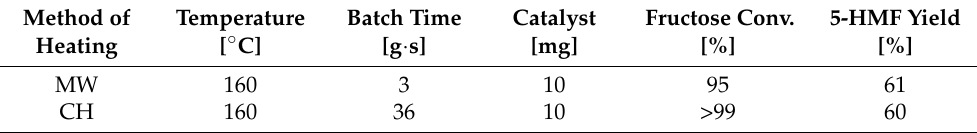
Table 5. Comparison between MW and CH for fructose dehydration. Reaction conditions: 100